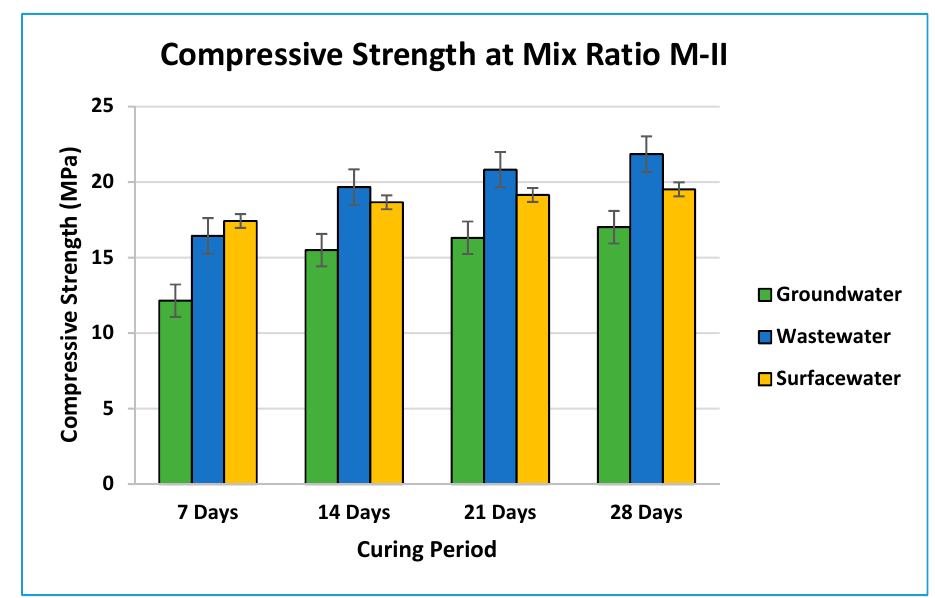
Figure 5. Cylinder compressive strength of concrete for the ratio M-II (1:1.5:3).